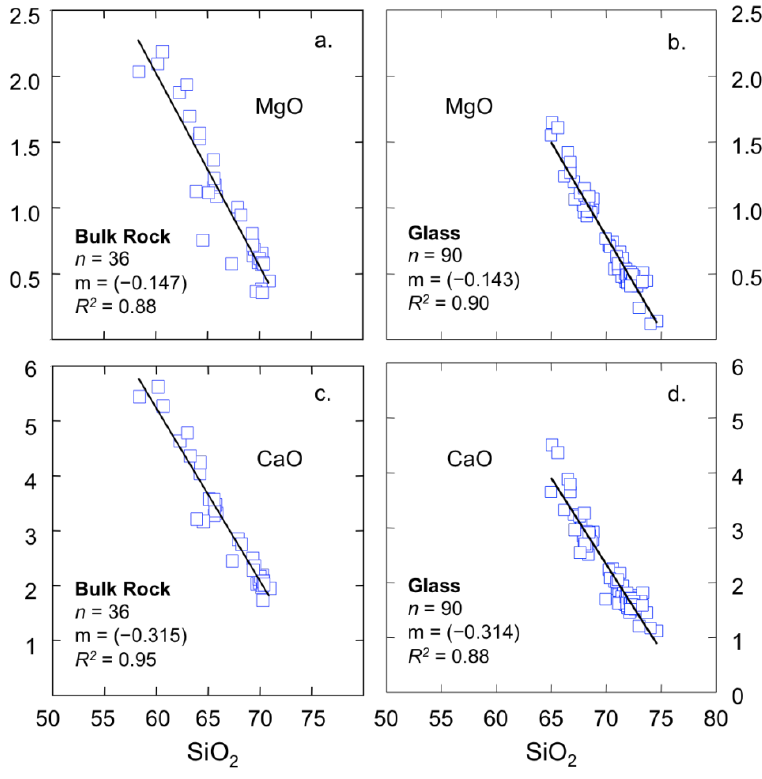
Figure 7. Plots of wt % MgO vs. wt % SiO in ( a ) Papagayo whole rock samples and 2 ( b ) groundmass glass; and wt % CaO vs. wt % SiO in ( c ) whole rock samples and 2 ( d ) groundmass glass. Linear trends in whole rock and glass analyses cover a similar 10 wt % range in SiO , >1.5 wt % range in MgO and 4 wt % range in CaO. Regressions lines for bulk 2 rock, and glass trends have similar slopes with R 2 ≥ 0.88.